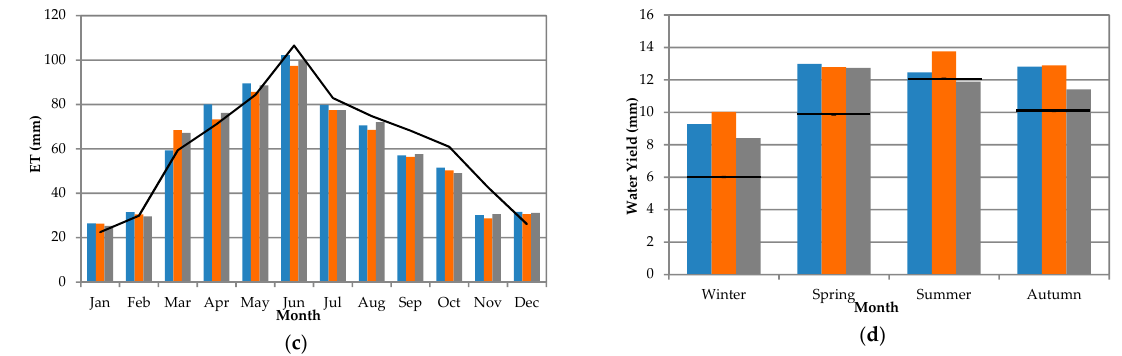
Figure 6. Model simulated ( a ) total monthly surface runoff, ( b ) total monthly water yield, ( c ) total